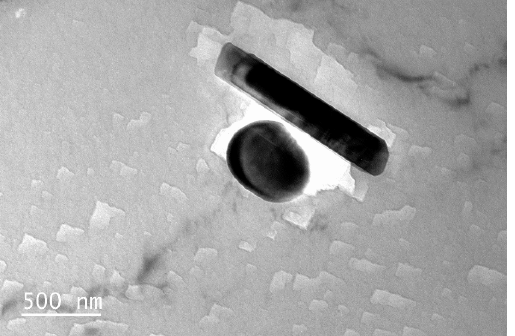
Figure 8. Microstructure characteristics of unirradiated LT21 aluminum alloy.